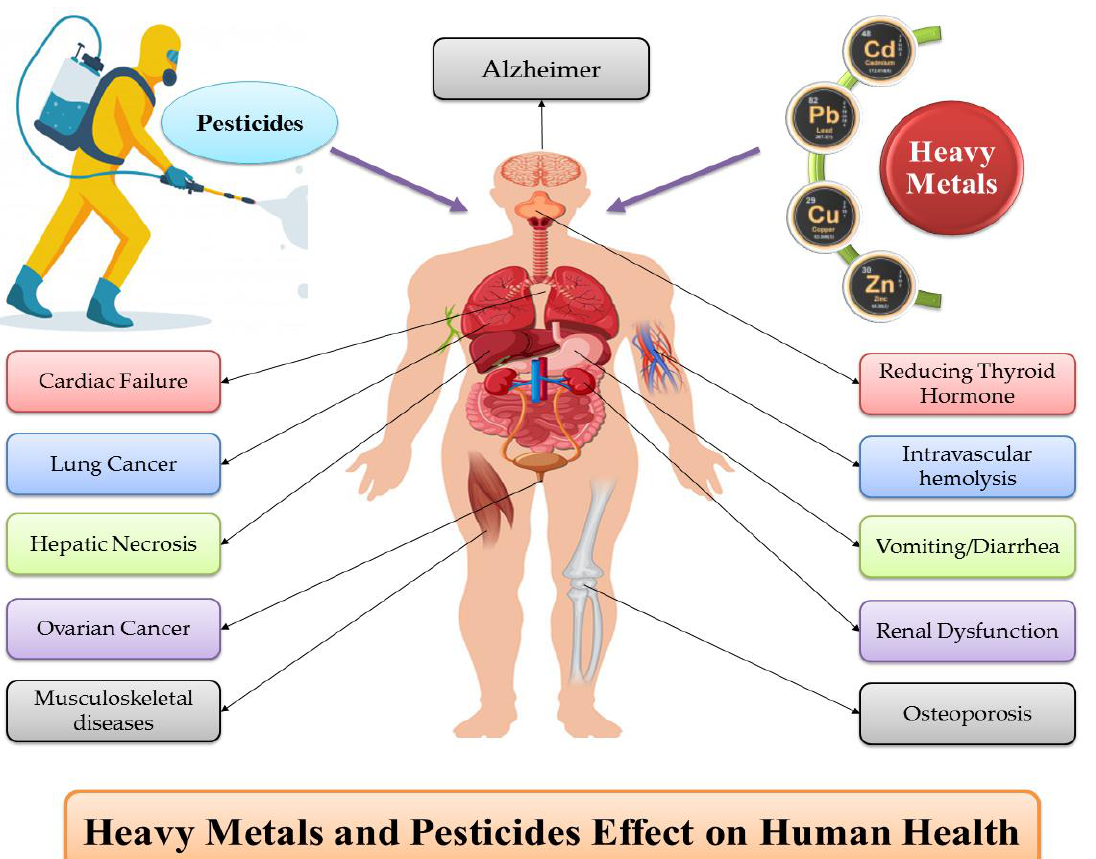
Figure 8. Negative effects of heavy metals and pesticides toxicity on human health.